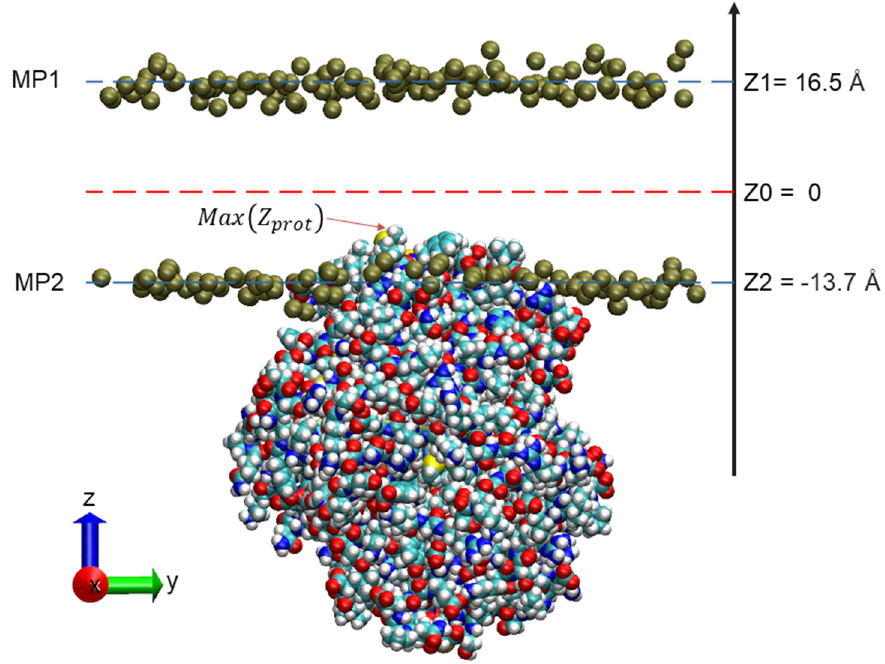
Figure 7. Three-dimensional view of the CCD4b inserted into the membrane. The phosphate groups (dark yellow balls) were aligned in the XY plane and projected on the Z axis. The first set MP2 includes all phosphate groups on the membrane side in which the protein was inserted. The second set MP1 includes the phosphate group belonging to the other layer of the membrane. Max(Z prot ) is the maximum atomic position observed for the protein along the Z axis for the 20 ns trajectory (not considering hydrogen atoms). Z1 and Z2 are the average values of the phosphate groups’ Z coordinates belonging to each